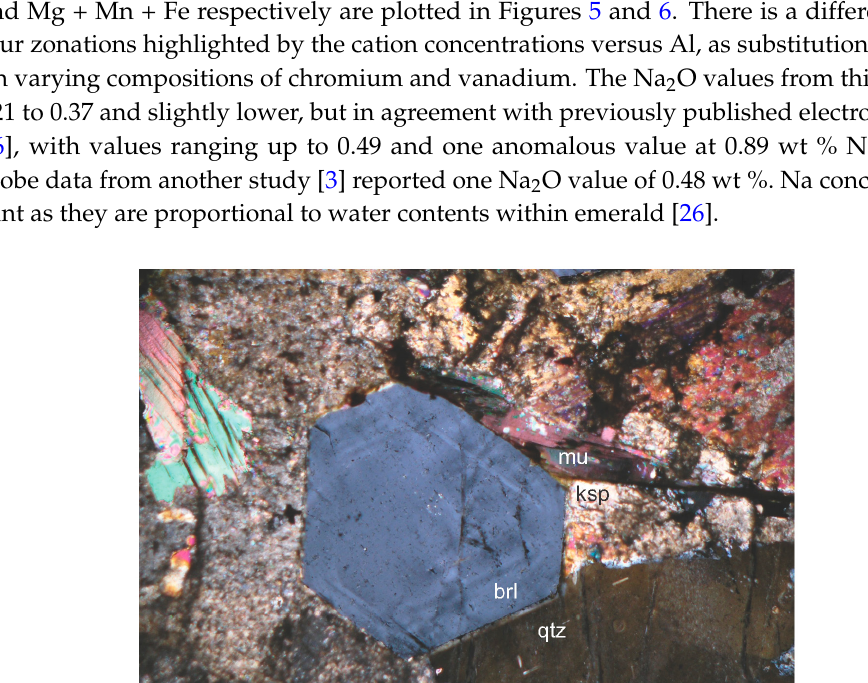
Figure 3. Electron microprobe data for FeO, Cr 2 O 3 , and V 2 O 3 superimposed on a